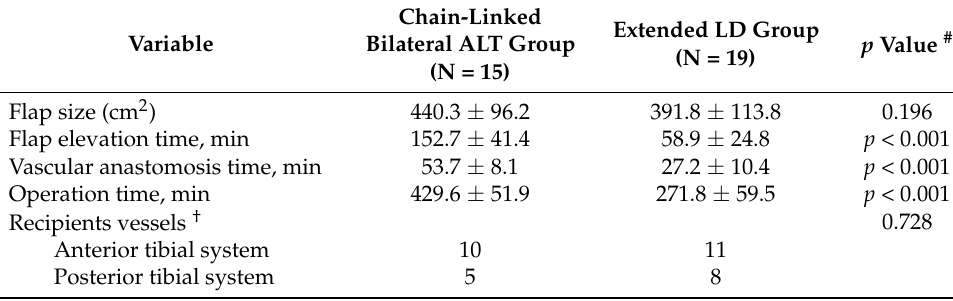
Table 2. Flap characteristics and intraoperative data.